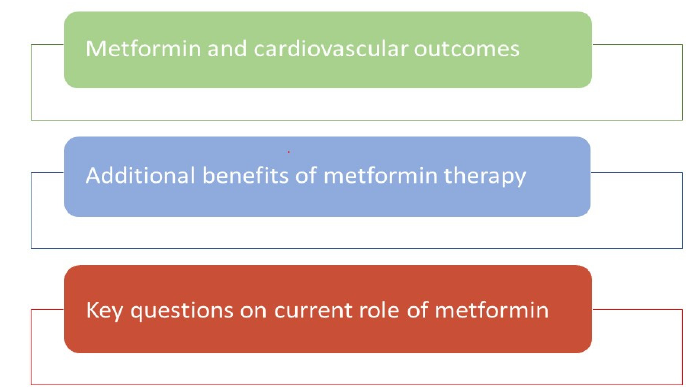
Figure 1. Summary diagram of individual sections.